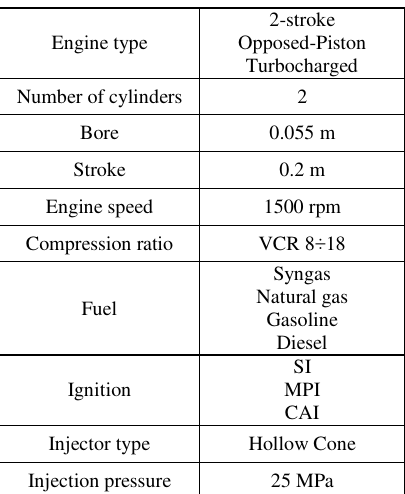
Table 1. Engine parameters